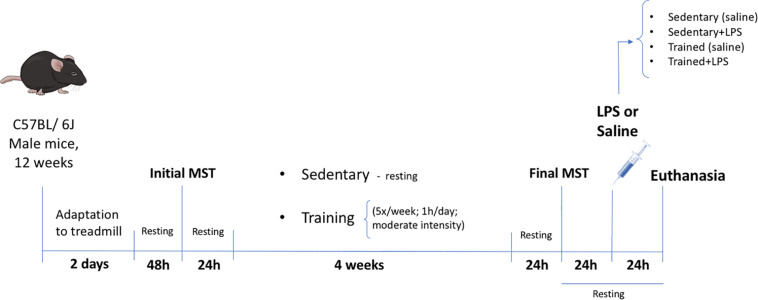
Experimental design. Twelve-week-old male C57BL/6J mice were adapted to a motor-driven treadmill for 2 days (first day 10 min; second day 10 min). After 2 days of resting, the animals were submitted to the first incremental load test until exhaustion (initial MST) for the definition of the training velocity (60% of initial MST). Twenty-four hours after the initial MST, the animals began the treadmill exercise or the resting period for 4 weeks. The last load speed test (final MST) was carried out 24 h after the last exercise session in order to confirm the training effectiveness through the performance improvement. The LPS (5 mg/kg) or saline was administered 24 h after the final MST. All animals were euthanized 24 h after LPS treatment by cervical dislocation.